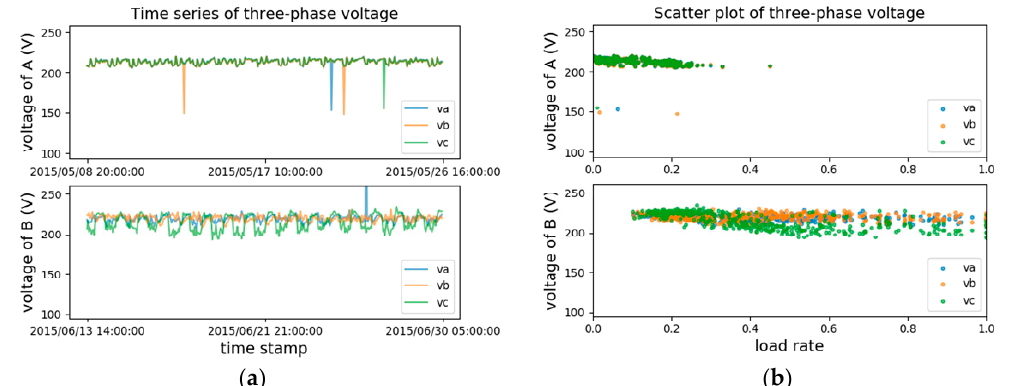
Figure 2. ( a ) Two time series from a normal (upper) and an abnormal (lower) customers respectively. ( b ) The corresponding scatter plots of the same piece of data with load rate being the x-axis. Voltage is collected once an hour and each time stamp is the collecting time.